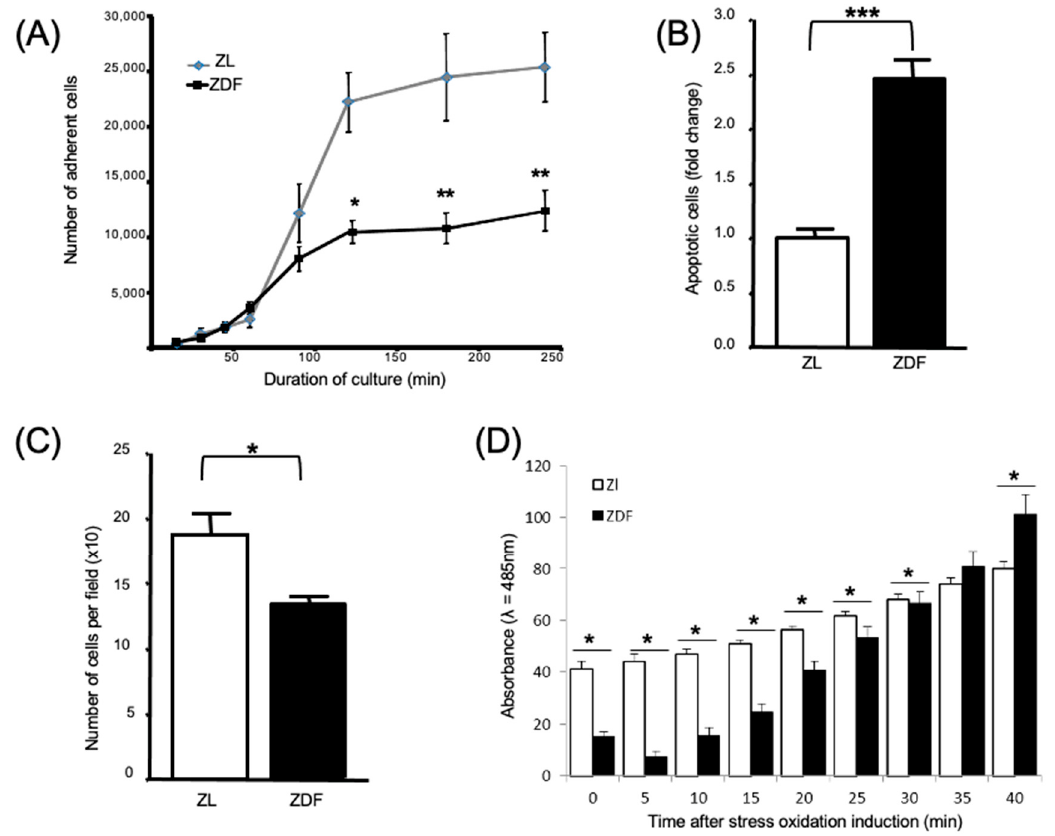
Figure 2. Impaired apoptosis, migration, adhesion, and Reactive Oxygen Species (ROS) production of ZDF-BMMSCs. ( A ) BMMSCs from ZDF and ZL rats were each seeded in 12-well culture plates, fixed using methanol–phosphate buffered saline (PBS) solution, and stained with Giemsa solution. Adherent cells were counted using the data processing software Image J. ( B ) Flow cytometry analysis of apoptosis using cells cultured under serum-free conditions for 48 h and stained with annexine-PI, ( C ) Cell migration was determined using commercially available 24-well Boyden chambers. Cells present on four randomly-chosen, separate areas per membrane were counted in situ. ( D ) Oxidative stress was induced by adding tert-butyl peroxide, then light absorbance ( λ = 485 nm) was measured every 5 min for 40 min. Values are mean ± SEM. The data are from 3 independent wells per condition tested in 3 independent experiments (n = 9). * P < 0.05; ** P < 0.01; *** P < 0.001.